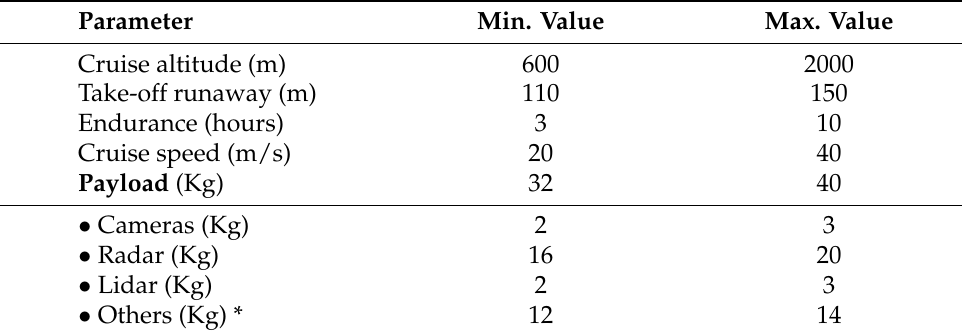
Figure 2. Galapagos Islands missions profiles. Table 1. Mission operating